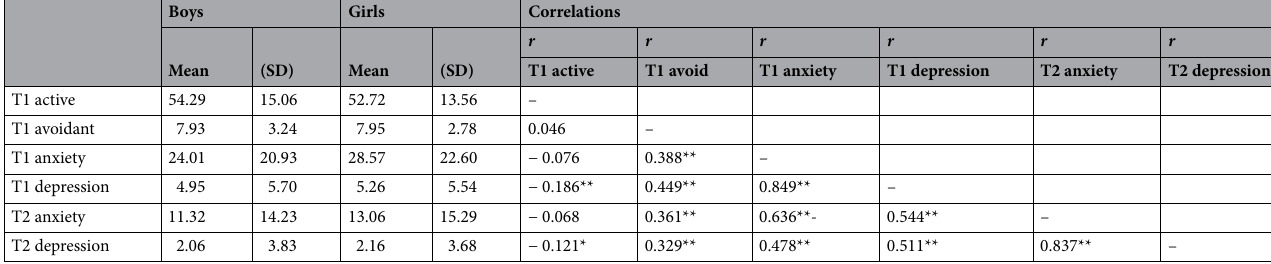
Table 1. Mean (standard deviation) and correlations of psychological variables (n = 321). Active = active coping style. Avoidant = avoidant coping style. ** p < .001, * p <